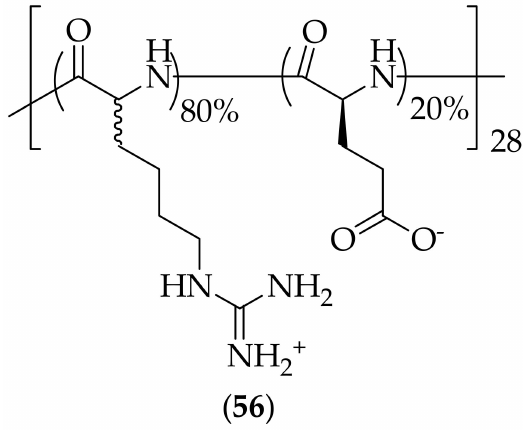
Figure 37. 28-Mer antifungal polymer ( 56